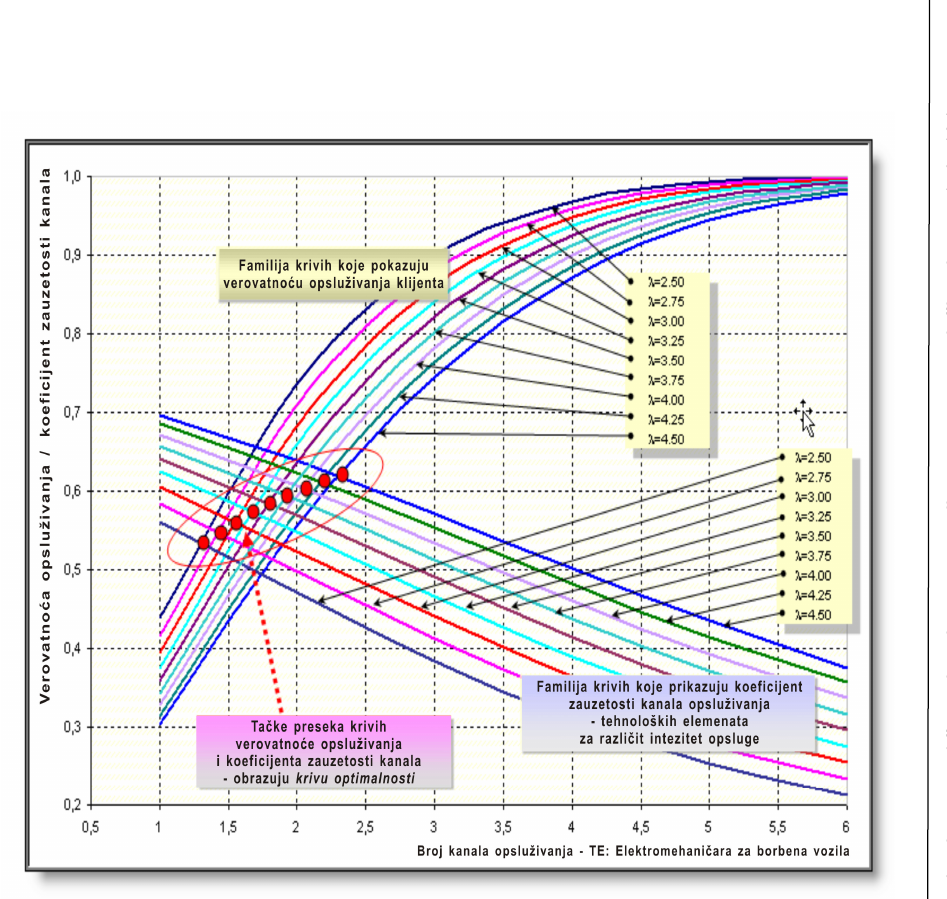
Figure 14 – Optimal values of the required number of TE